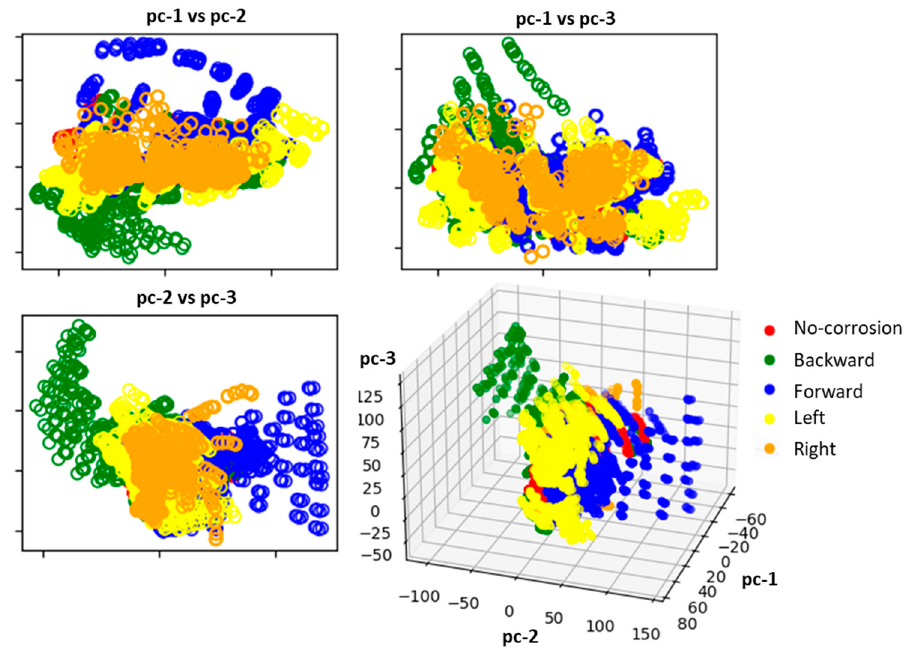
Figure 7. Projection of dataset on three principal components.